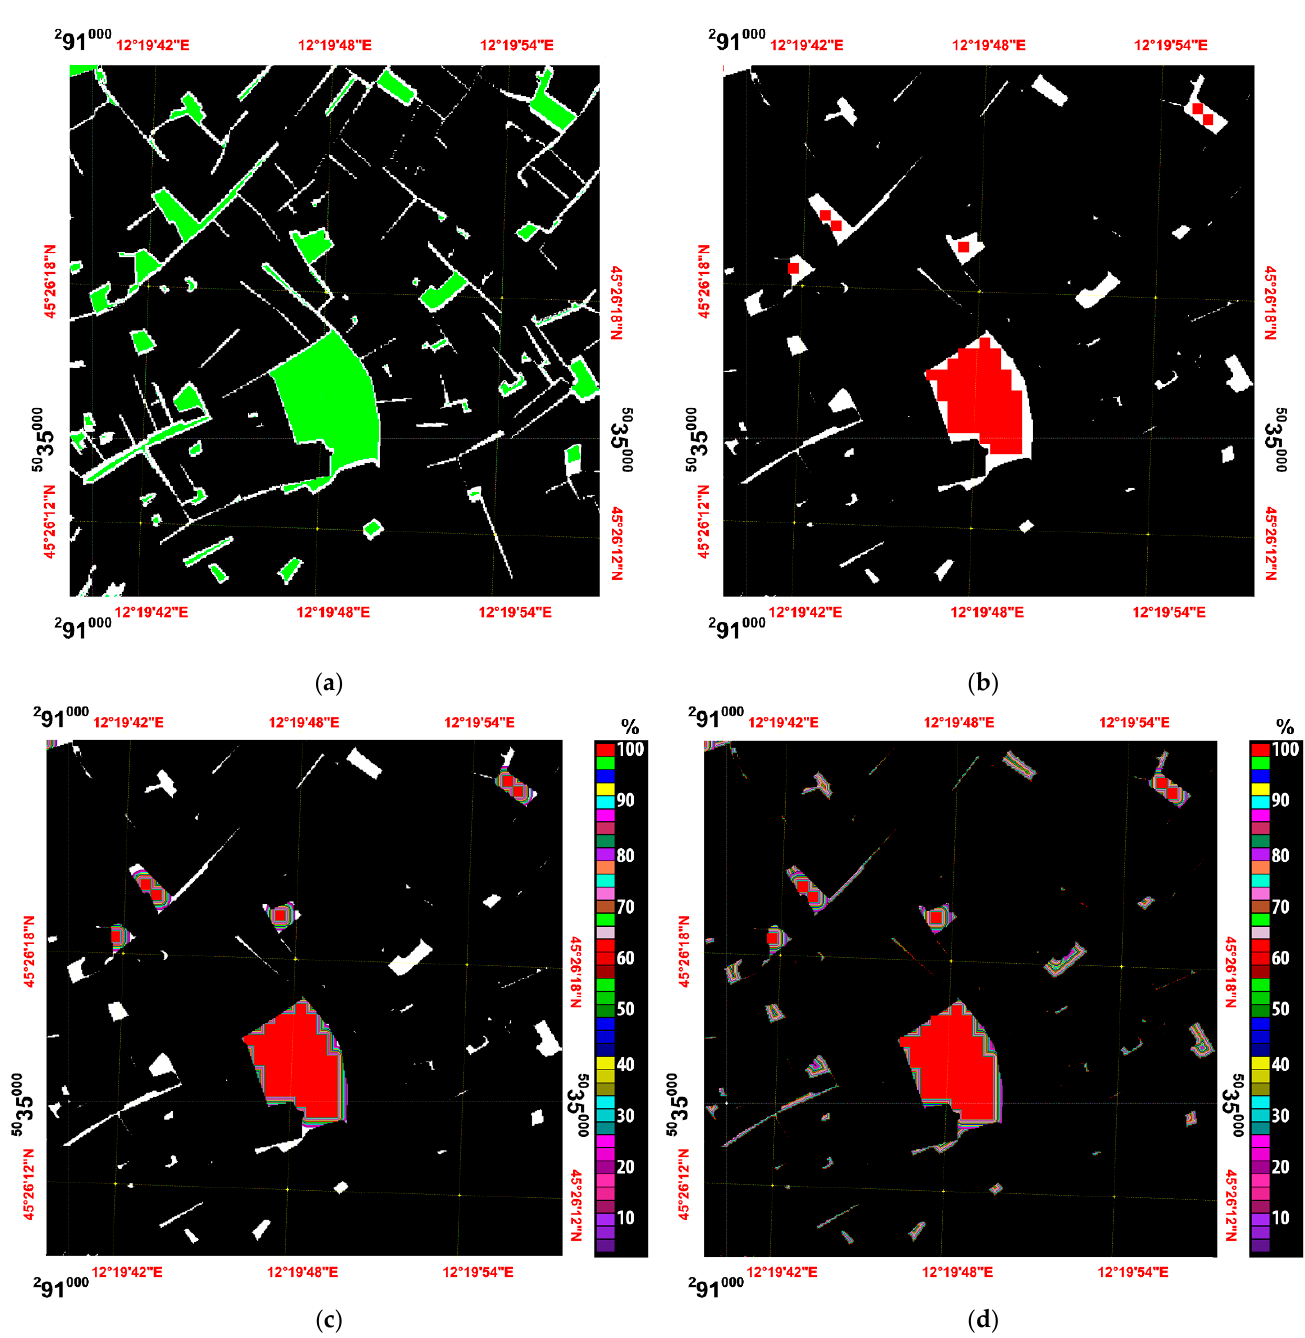
Figure 5. The procedure of fractional abundance determining applied to trachyte endmember is shown: ( a ) the validated reference map at 0.20 m (green) superimposed on the previous reference map (white); ( b ) the pixels with 100% abundance (red) superimposed on the validated reference map (white); ( c ) reference fractional abundance map determined only for areas surrounding those with 100% abundance; colors with corresponding percentages are shown on the right; ( d ) the completed reference fractional abundance map highlighted with a color ramp; colors with corresponding percentages are shown on the